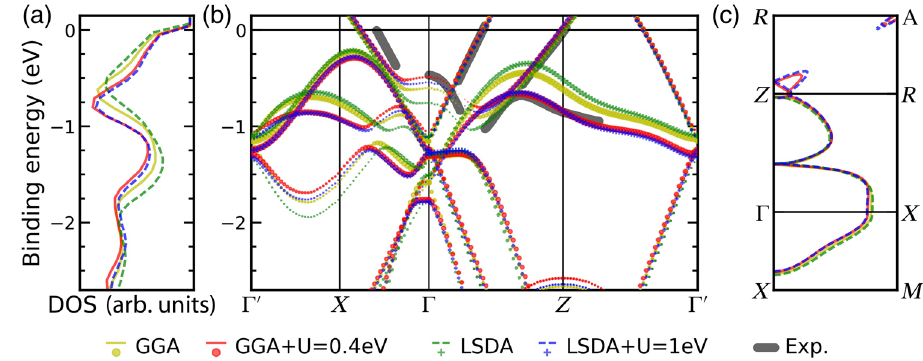
FIG. 3. DFT þ U calculations under variation of U : (a) DOS, (b) unfolded bands along the Γ 0 - X - Γ - Z - Γ 0 directions (majority spin eff only), and (c) corresponding FS. The best match to the experimental bands extracted from ARPES data ( “ Exp. ” ) is achieved with ¼ 0 . 4 eV for the GGA and 1 eV for the LSDA exchange-correlation U eff